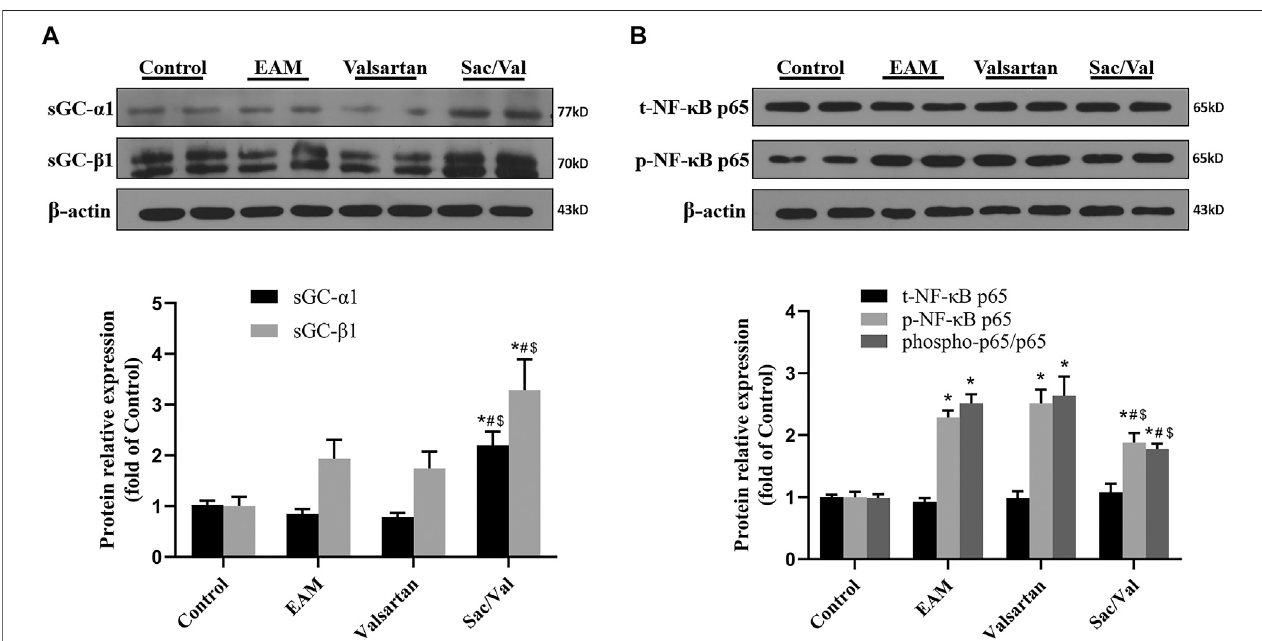
FIGURE5| sGCandNF- κ Bp65functionedassignalingmolecules. (A) RepresentativewesternblottingimagesandstatisticalanalysisforcardiacsGC- α 1andsGC- β 1. (B) Representativewesternblottingimagesandstatisticalanalysisforcardiacphospho-/total-NF- κ Bp65signalingpathway.Allexperimentshadsixmicepergroupanddata were expressed as means ± SEM and analysed by one-way ANOVA. * p < 0.05 vs. Control group; # p < 0.05 vs. EAM group; $ p < 0.05 vs. Valsartan group.